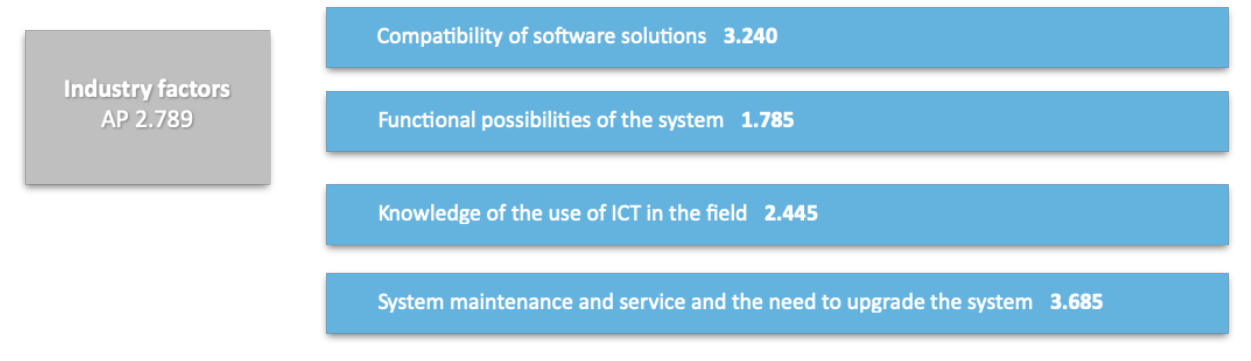
Figure 1. Implementation factor groups and impact rates.